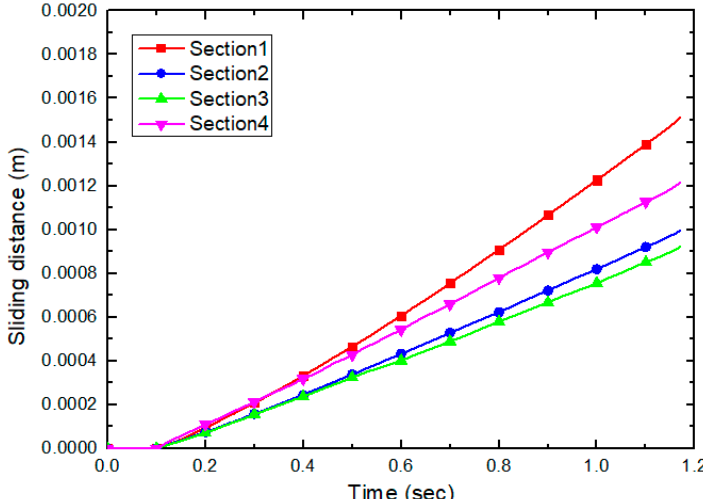
Figure 21. History of average cumulative sliding distance.